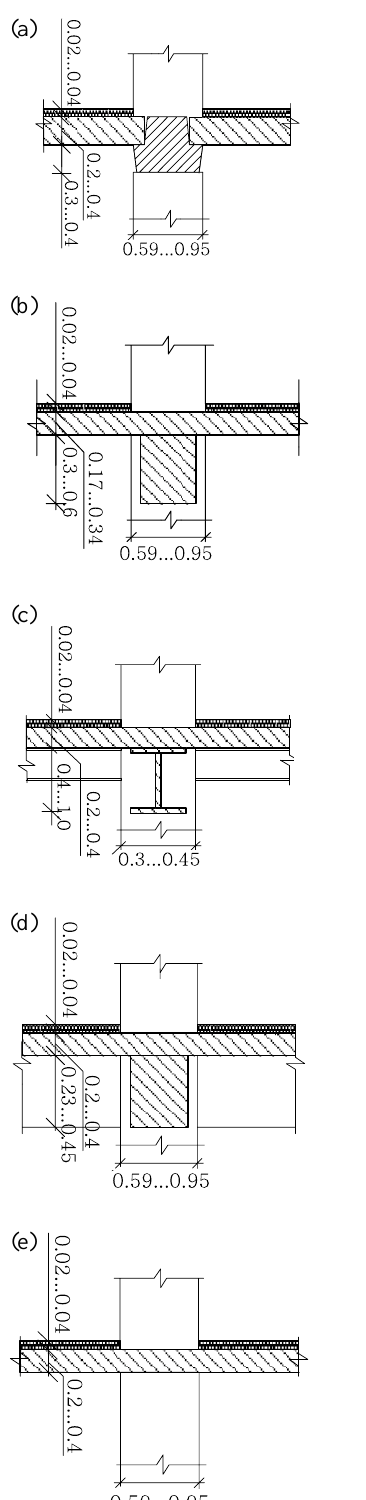
Fig. 4. Possible alternatives for a structural system of a high- rise building: a) semi-rigid frame (sectional monolithic concrete) (cid:1) A 1 ; b) semi-rigid frame (monolithic concrete) (cid:1) A 2 ; c) semi-rigid frame (steel beams and columns, concrete frame without beams (monolithic concrete) (cid:1) A